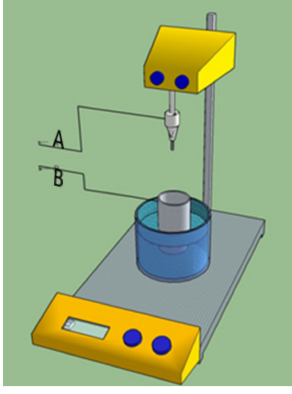
Figure 8. The simple set-up used for nanotubes growth on titanium implant, cables ( A ) and ( B ) were connected to the power supply